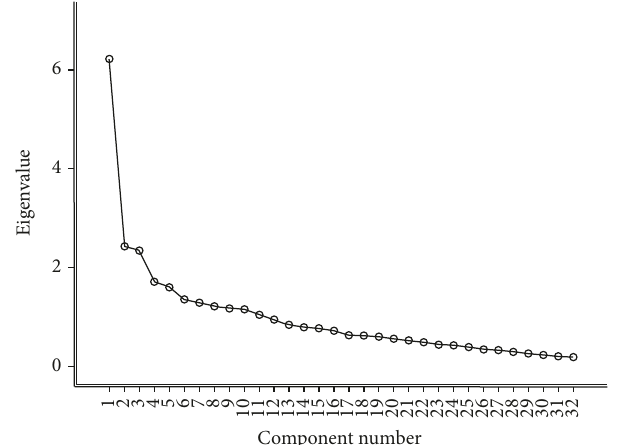
Figure 1: Scree plot of the results of a principal components analysis of the 32-item MARSI questionnaire among medical undergraduate students.